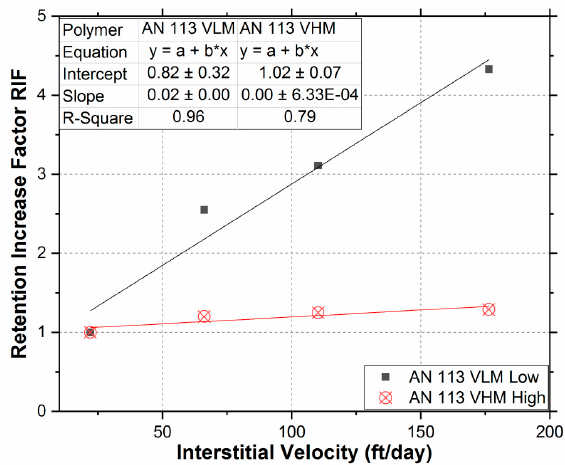
Figure 6. The increase in polymer retention factor with interstitial velocity.